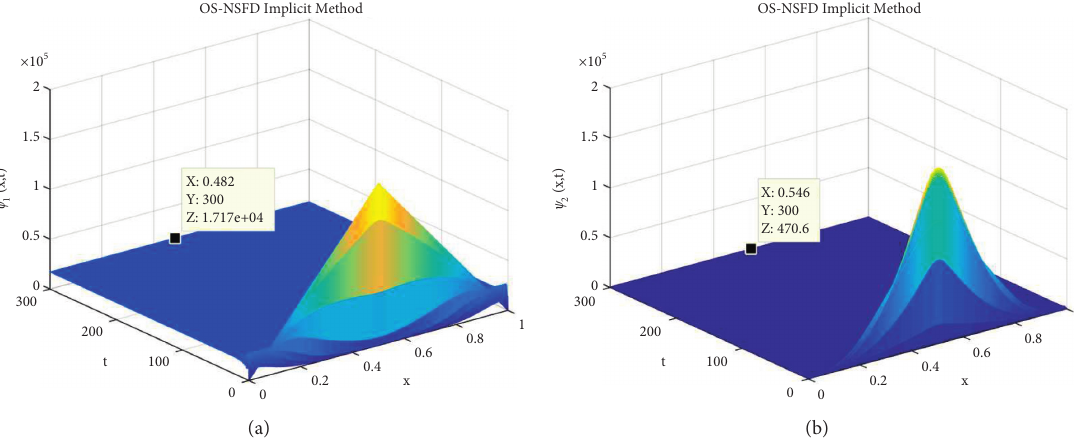
Figure 15: Solution graphs of ψ and ψ (susceptible and infected population densities) using the NSFD implicit splitting method at 1 2 � λ � 125. (a) Solution graph of ψ κ � 0 . 002 , λ . (b) Solution graph of ψ 1 2 1